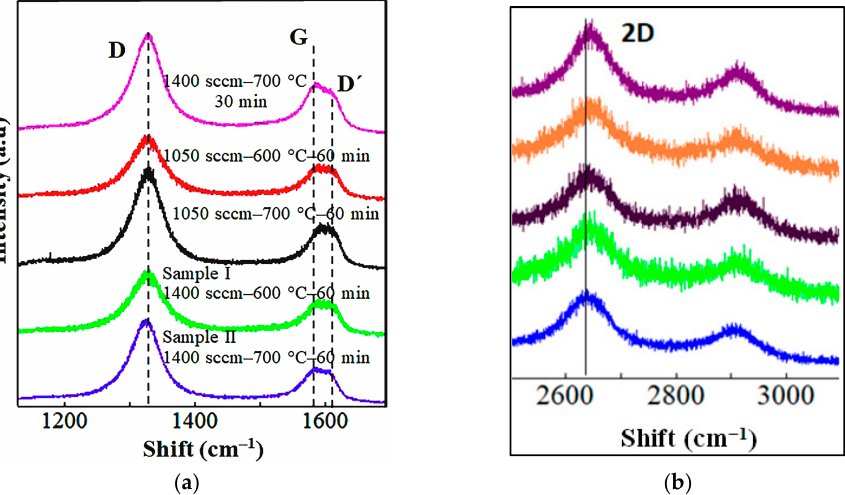
Figure 4. The RAMAN spectra for the CNWs grown at 30 min with 1400 sccm − 700 °C (purple line) and at 60 min with 1050 sccm − 600 °C (red line), 1050 sccm − 700 °C (black line), 1400 sccm − 600 °C (green line) and 1400 sccm − 700 °C (blue line). The figure includes ( a ) the D and G bands and ( b ) 2D bands.